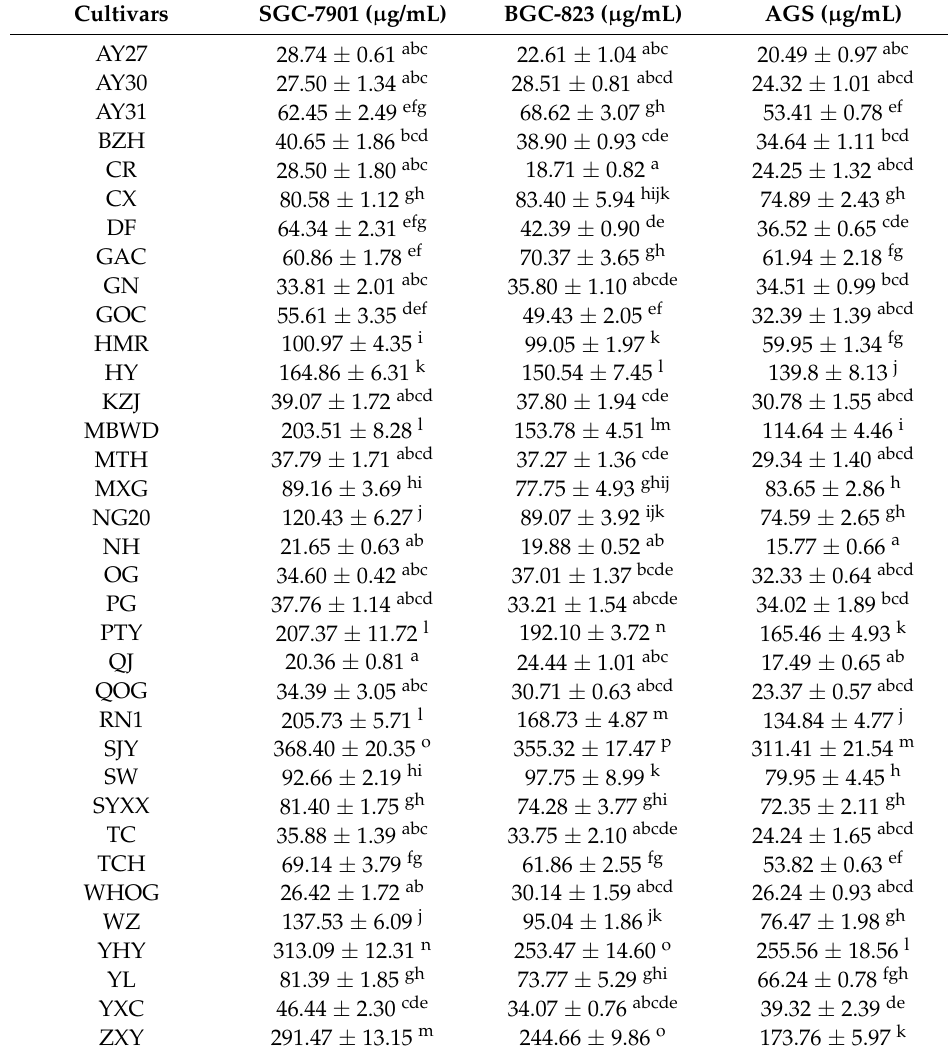
Table 6. The IC 50 value of citrus flavedo extracts treatment to three gastric cancer cell